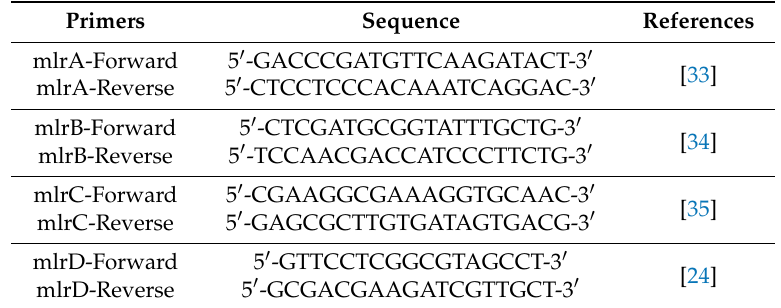
Table 1. Specific primer